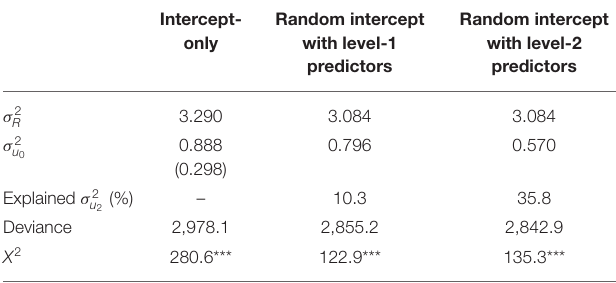
TABLE 3 | Rescaled estimates of individual ( σ 2 R ) and country residual variance ( σ 2